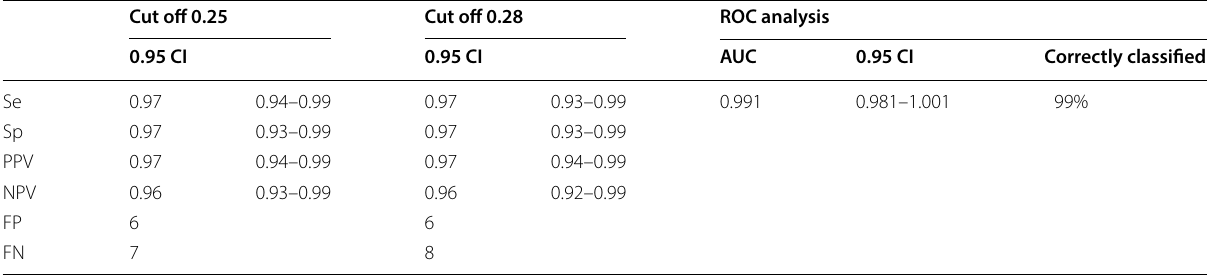
Se sensitivity, Sp specificity, PPV positive predictive value, NPV negative predictive value, FP false positive, FN false negative, AUC area under the ROC curve, CI confidence interval